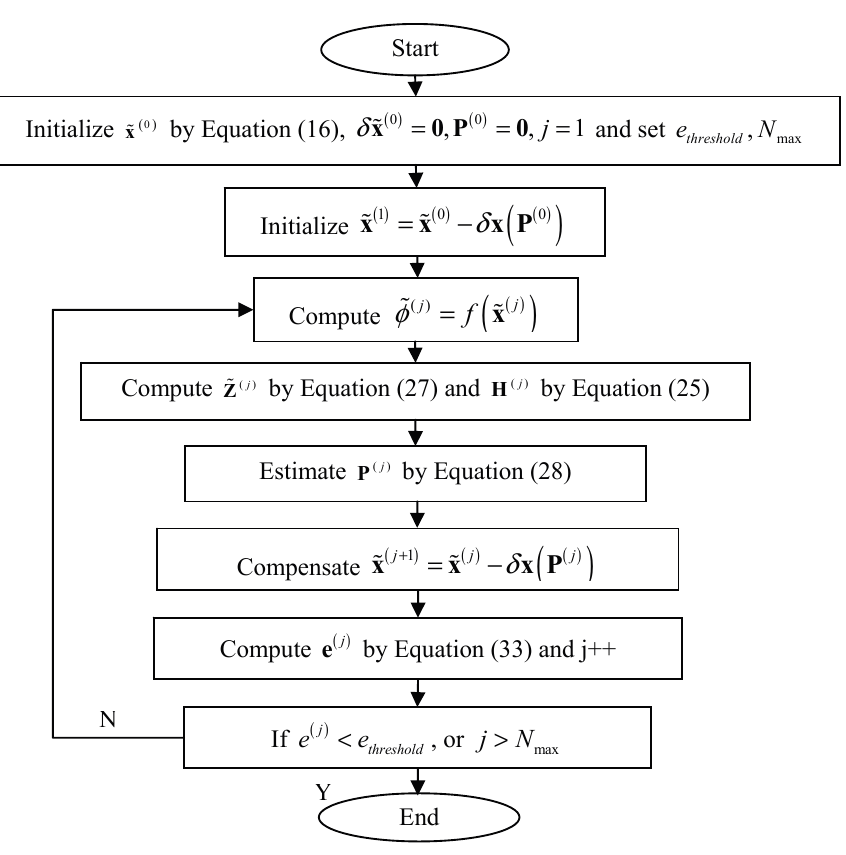
Figure 4. The flowchart of the implementation of our calibration